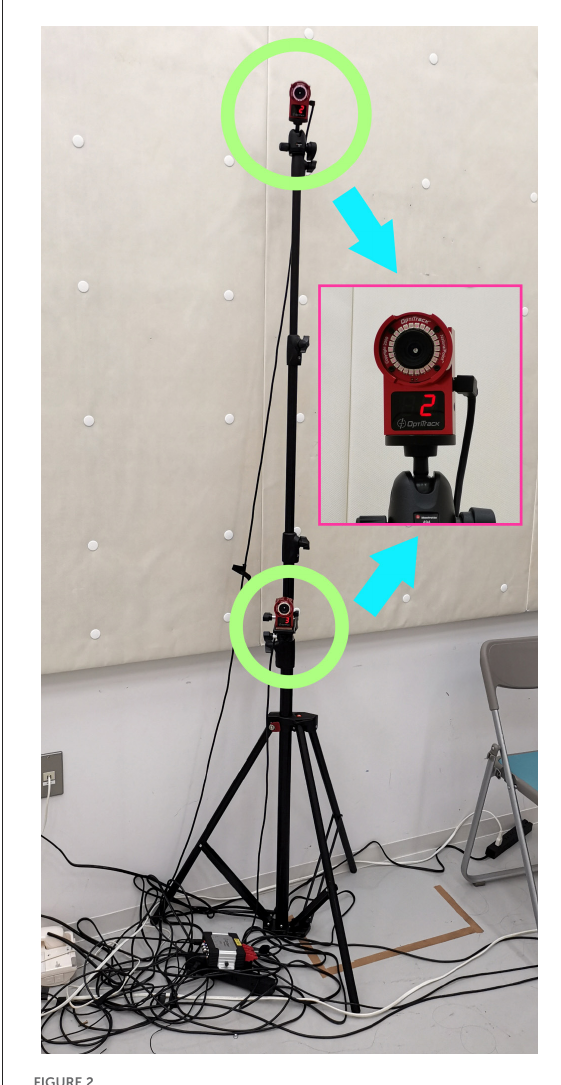
FIGURE2 Two OptiTrack Flex 3 cameras installed on one camera stand at different heights.